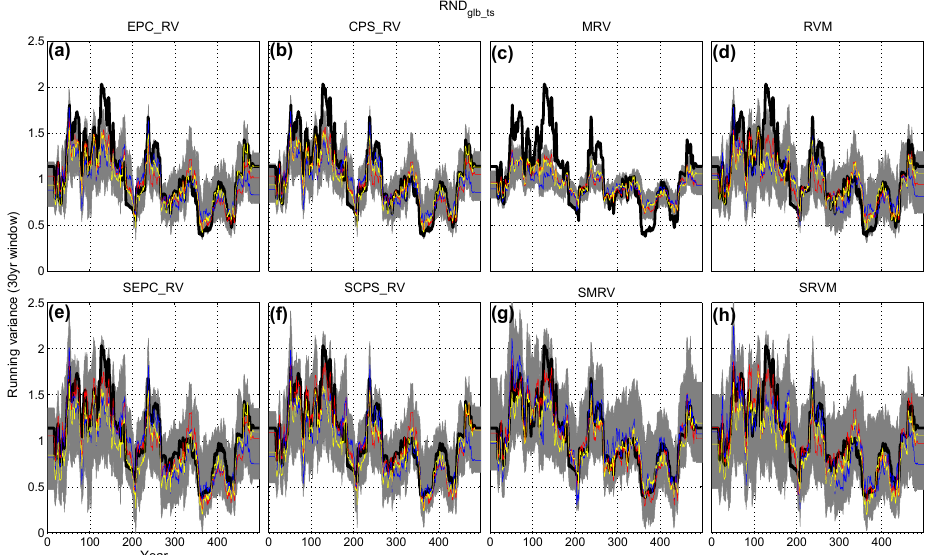
Figure 10. The reconstructed Niño 3.4 running variance range of various methods (grey shading) plotted with the model Niño 3.4 running variance. The first row of panels shows the unscaled reconstruction methods, while the second row has been scaled with a linear regression. Reconstruction methods are indicated in the title above the panel, and the scaled variants are named beginning with an “S”. The year of the reconstruction is shown on the x axis of these panels. Running variances are calculated using 30-year moving windows. Some example reconstructions (red, yellow and blue lines) are shown, with the colours corresponding to a specific network of pseudoproxies. These reconstructions are from the RND glb_ts experiment, with a 91-year calibration